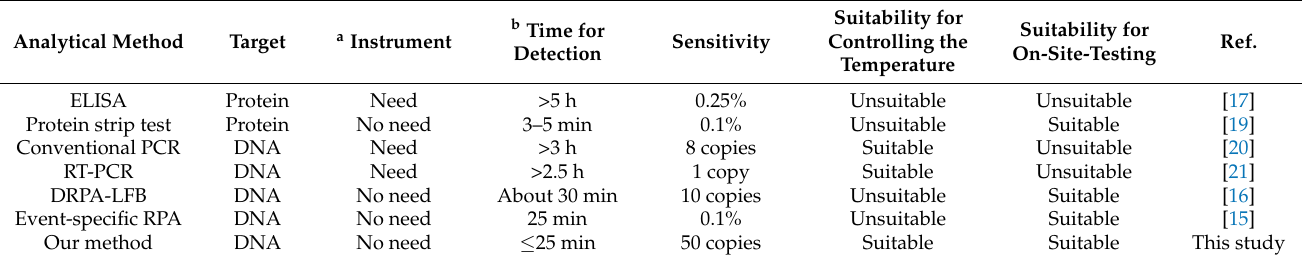
Table 1. Comparison of different detection methods.